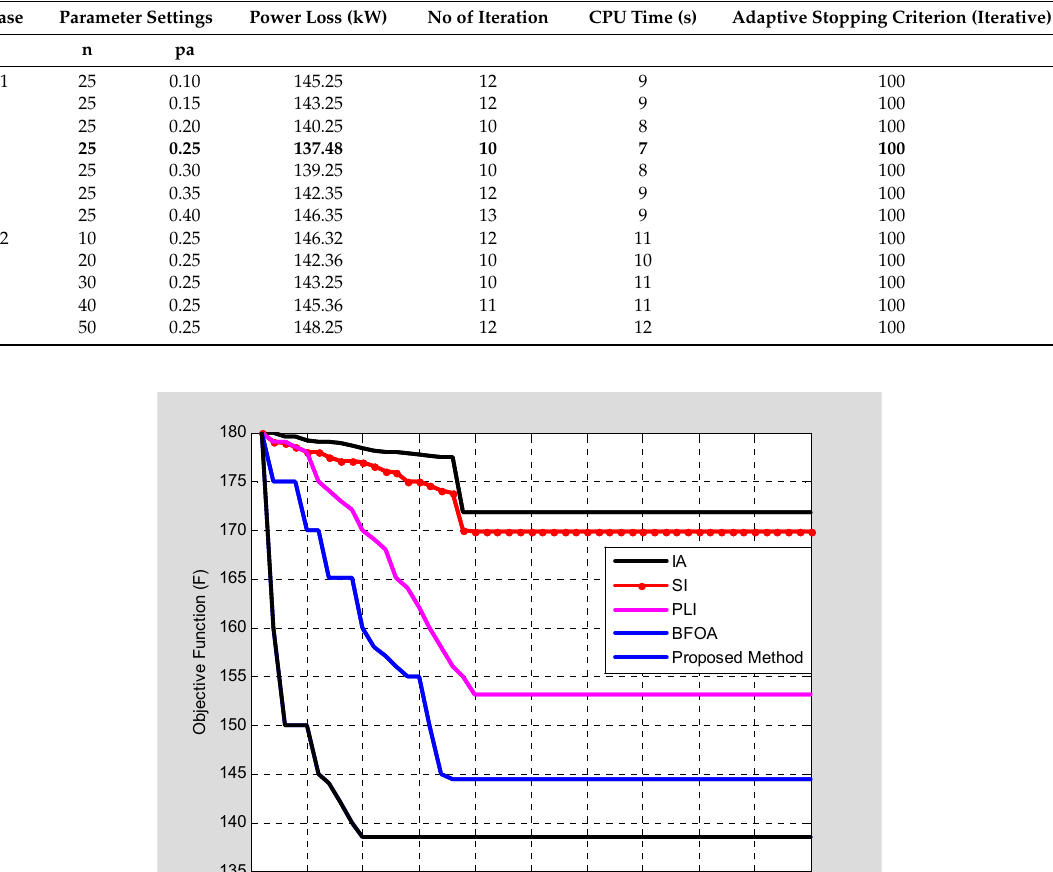
Figure 5. Comparison of power loss reduction by CSA with other classical techniques. Table 4. Optimal parameter setting of CSA for 33-bus system.